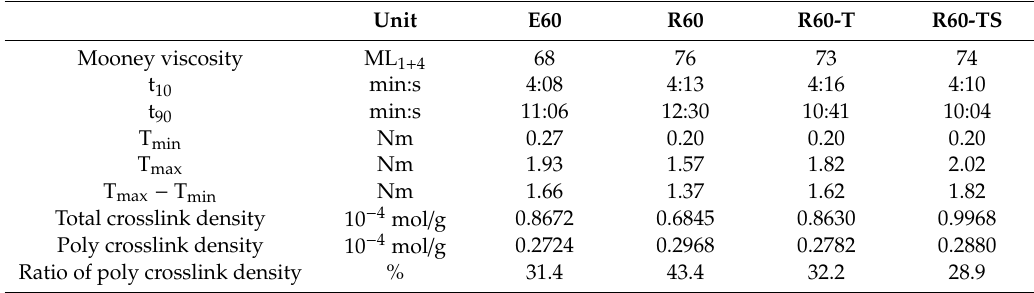
Figure 11. Crosslink densities of vulcanizates of carbon black-filled compound with a controlled cure system. Table 9. Cure characteristics and crosslink densities of emulsion styrene butadiene rubber (ESBR) and reversible addition-fragmentation radical transfer (RAFT) ESBR carbon black-filled compounds with a controlled cure system.